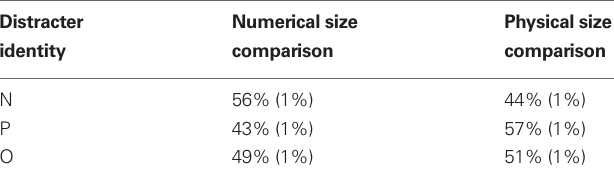
Table 1 | Task choice proportion as a function of distracter